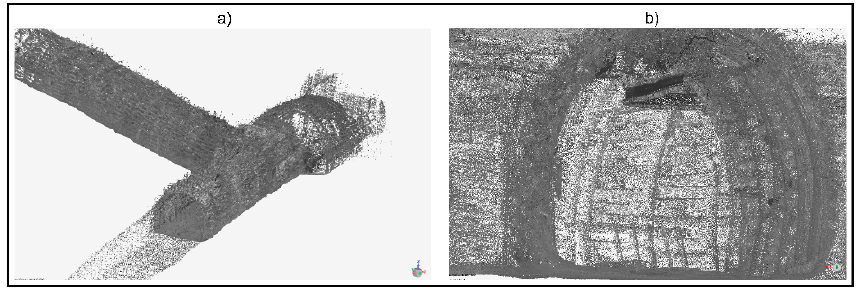
Figure 2. Examples of point clouds, containing transportation